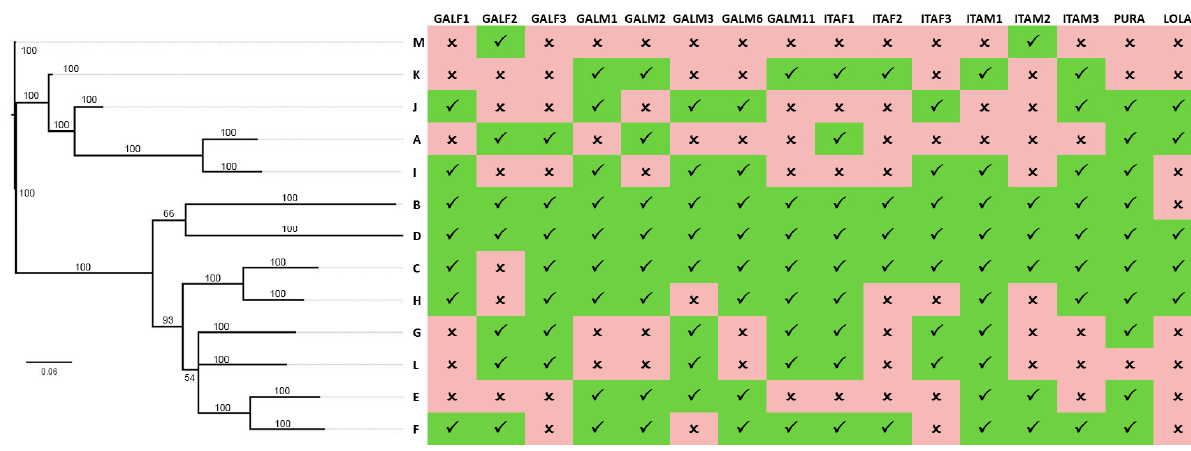
Figure 3. Clusters presence/absence variation. Matrix shows presence/absence of the 13 mytimycin clusters in all genomes, along with a Bayesian phylogenetic tree. Numbers close to each node are posterior probabilities.